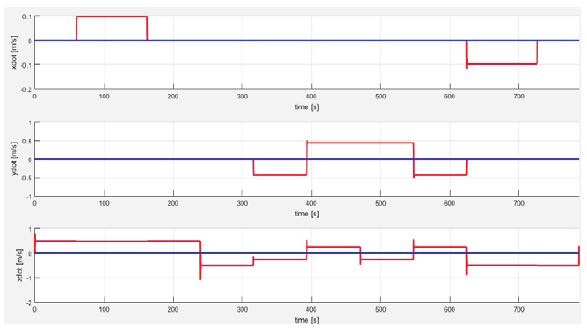
Figure 8. Velocity oscillations with respect to